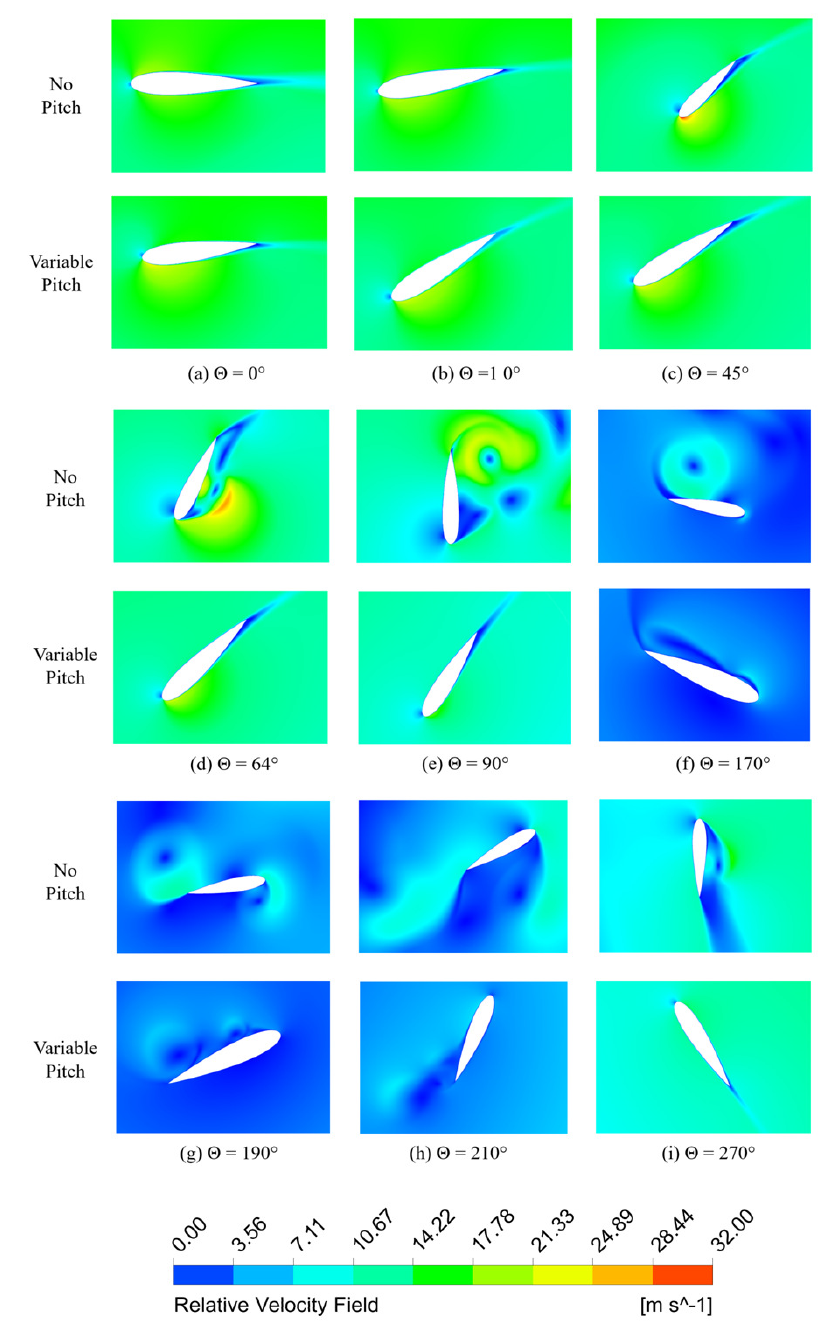
Figure 16. Relative velocity field around the no-pitch and variable-pitch blades at different az- imuthal